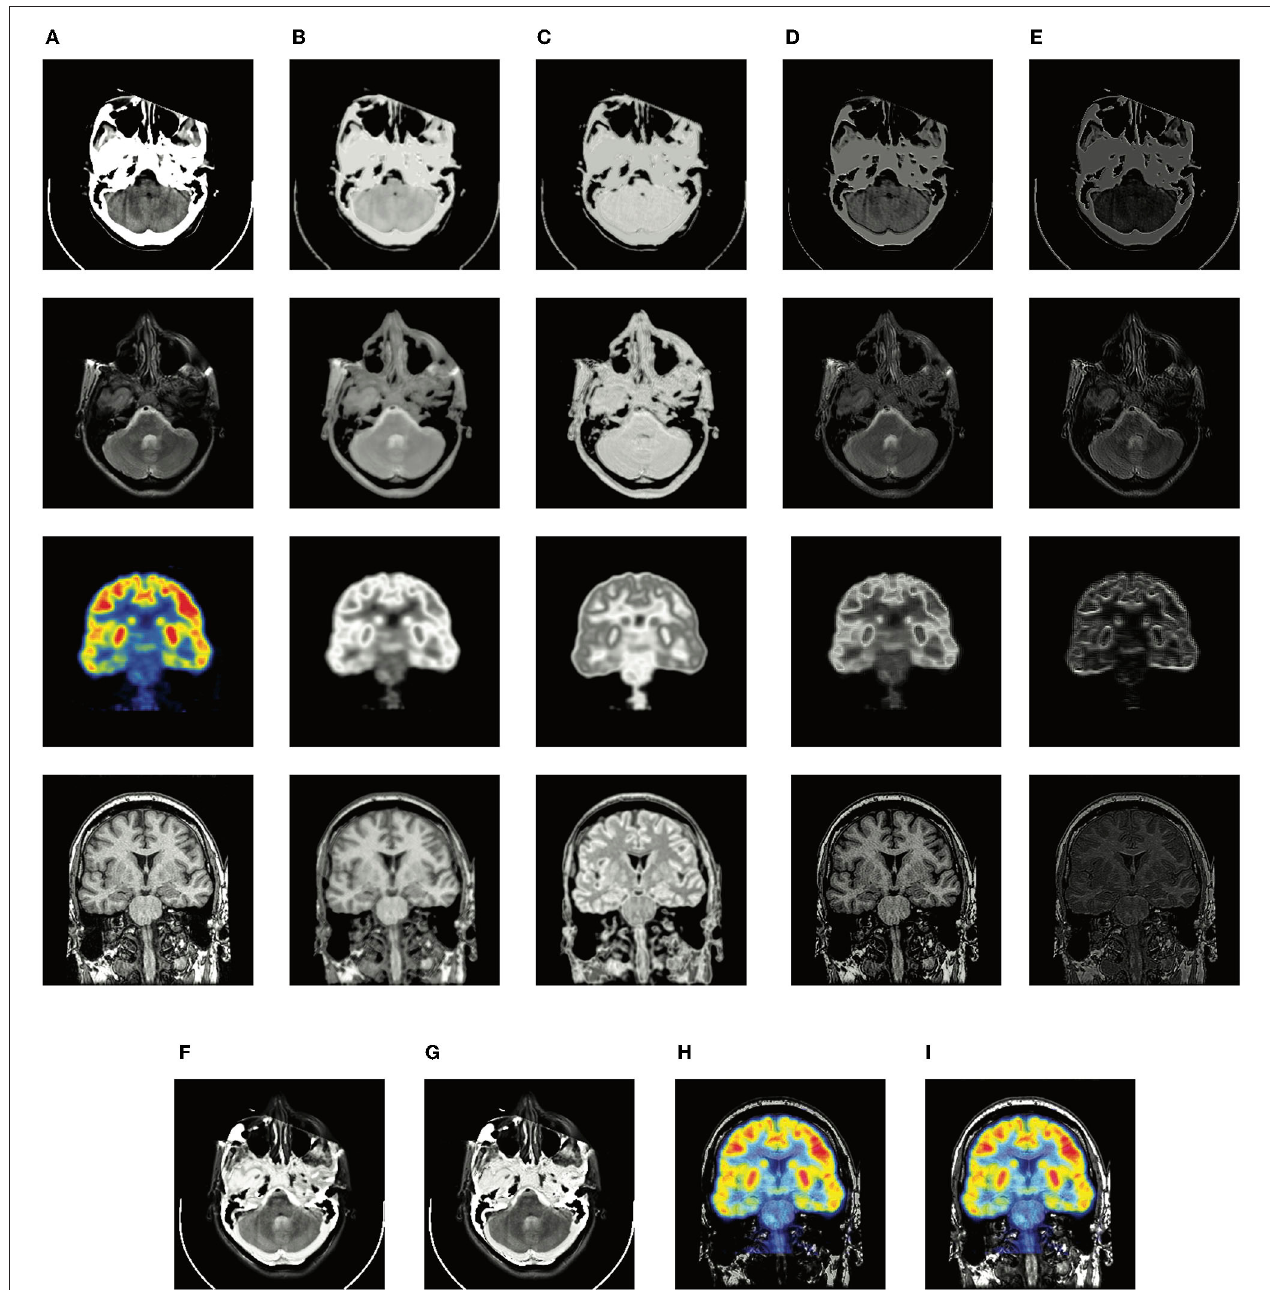
FIGURE 3 | The illustration of visualized feature maps and fused results without and with complementary group lasso penalty term L c . (A) source images; (B) the redundant features of the proposed method without L c ; (C) the redundant features of the proposed method; (D) the complementary features of the proposed method without L c ; (E) the complementary features of the proposed method; (F,H) the fused results of the proposed-add without L c ; (G,I) the fused results of the